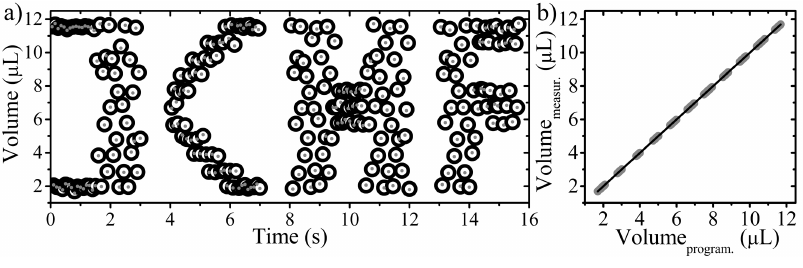
Figure 5. ( a ) The graph shows the pre-programmed (dots) and measured (open circles) volumes of droplets produced at 50 Hz in our system. The droplets were formed in 400 × 400 μ m 2 square cross-section channel. The scatter is intentional—o fill in the “body” of the letters coding for ICHF, the acronym of the Institute of Physical Chemistry (Instytut CHemii Fizycznej, Warszawa, Poland). ( b ) The graph illustrates the same sequence of droplets and shows the accuracy in forming of droplet on demand. Pearson correlation coefficient between measured and programmed volume of droplet is